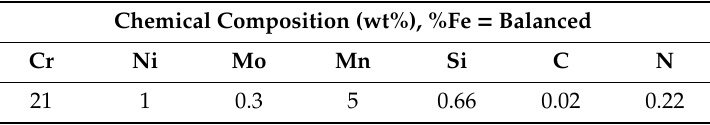
Table 1. Chemical composition of LDX-2101